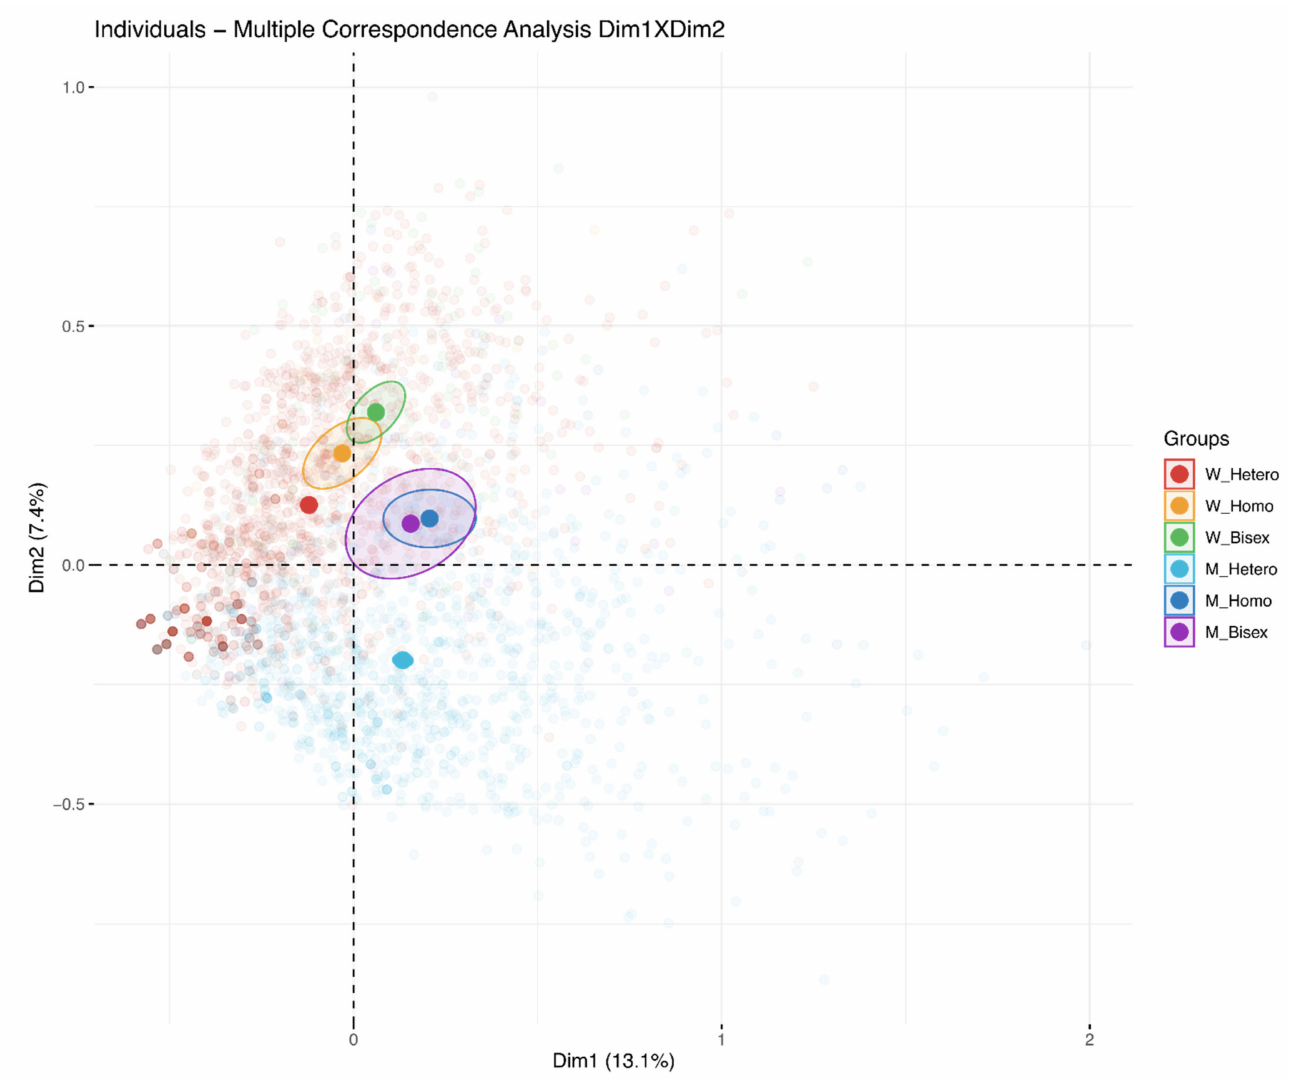
Figure 3. Individuals and groups along the MCA principal dimensions. The figure shows a geometrical representation of individuals (semitransparent dots) and groups (solid dots) along principal MCA dimensions. Ellipses represent the 95% confidence interval for each group. W_Hetero = heterosexual women; W_Homo = homosexual women/lesbians; W_Bisex = bisexual women; M_Hetero = heterosexual men; M_Homo = homosexual men; M_Bisex = bisexual